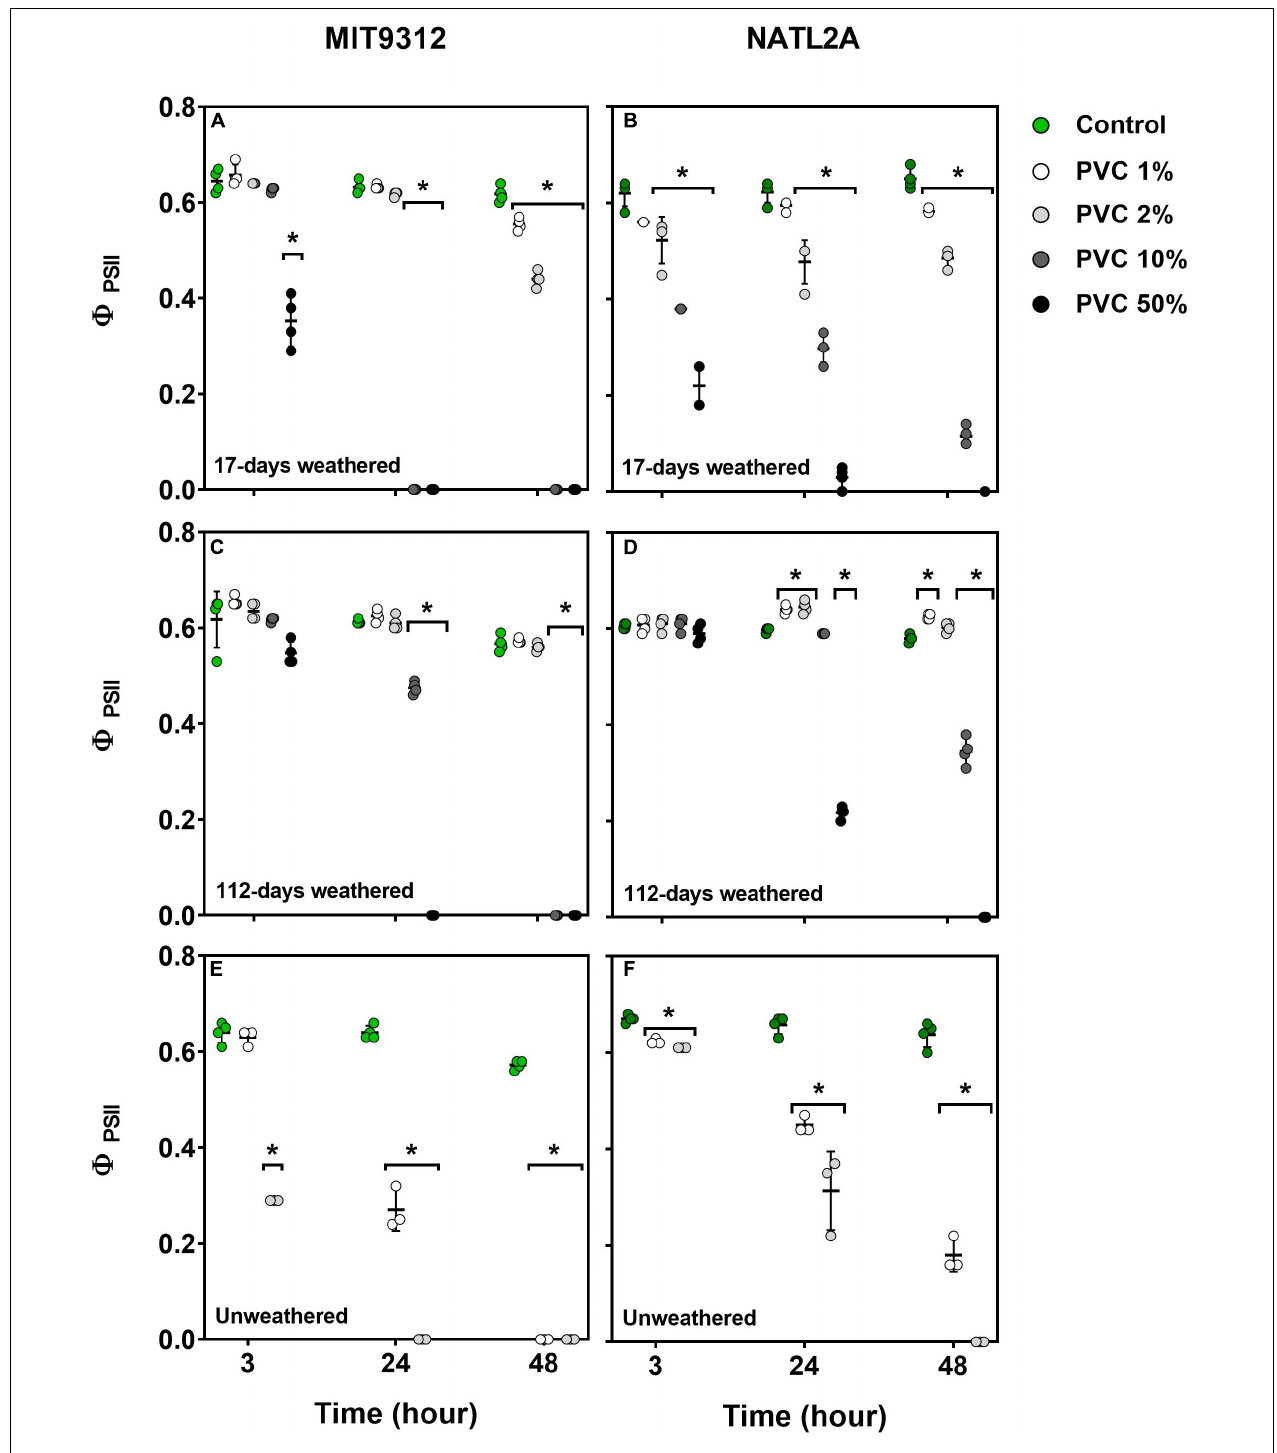
FIGURE 3 | Effective quantum yield of photosystem II ( (cid:56) PSII ) for Prochlorococcus MIT9312 and NATL2A exposed to different dilutions of PVC leachates ( A,B , weathered for 17-days; C,D , weathered for 112-days; E,F , unweathered) following different exposure times. Experiments were conducted over 48 h using biological replicates ( n = 4 for all weathered control and leachate treatments; n = 3 for all unweathered control and leachate treatments). Symbols represent the value for each replication, the bar represents the mean ± standard deviations for the treatment at each time point. Asterisks (*) signify treatments for which measurements were significantly ( p < 0.01) different comparing to the control at the examined